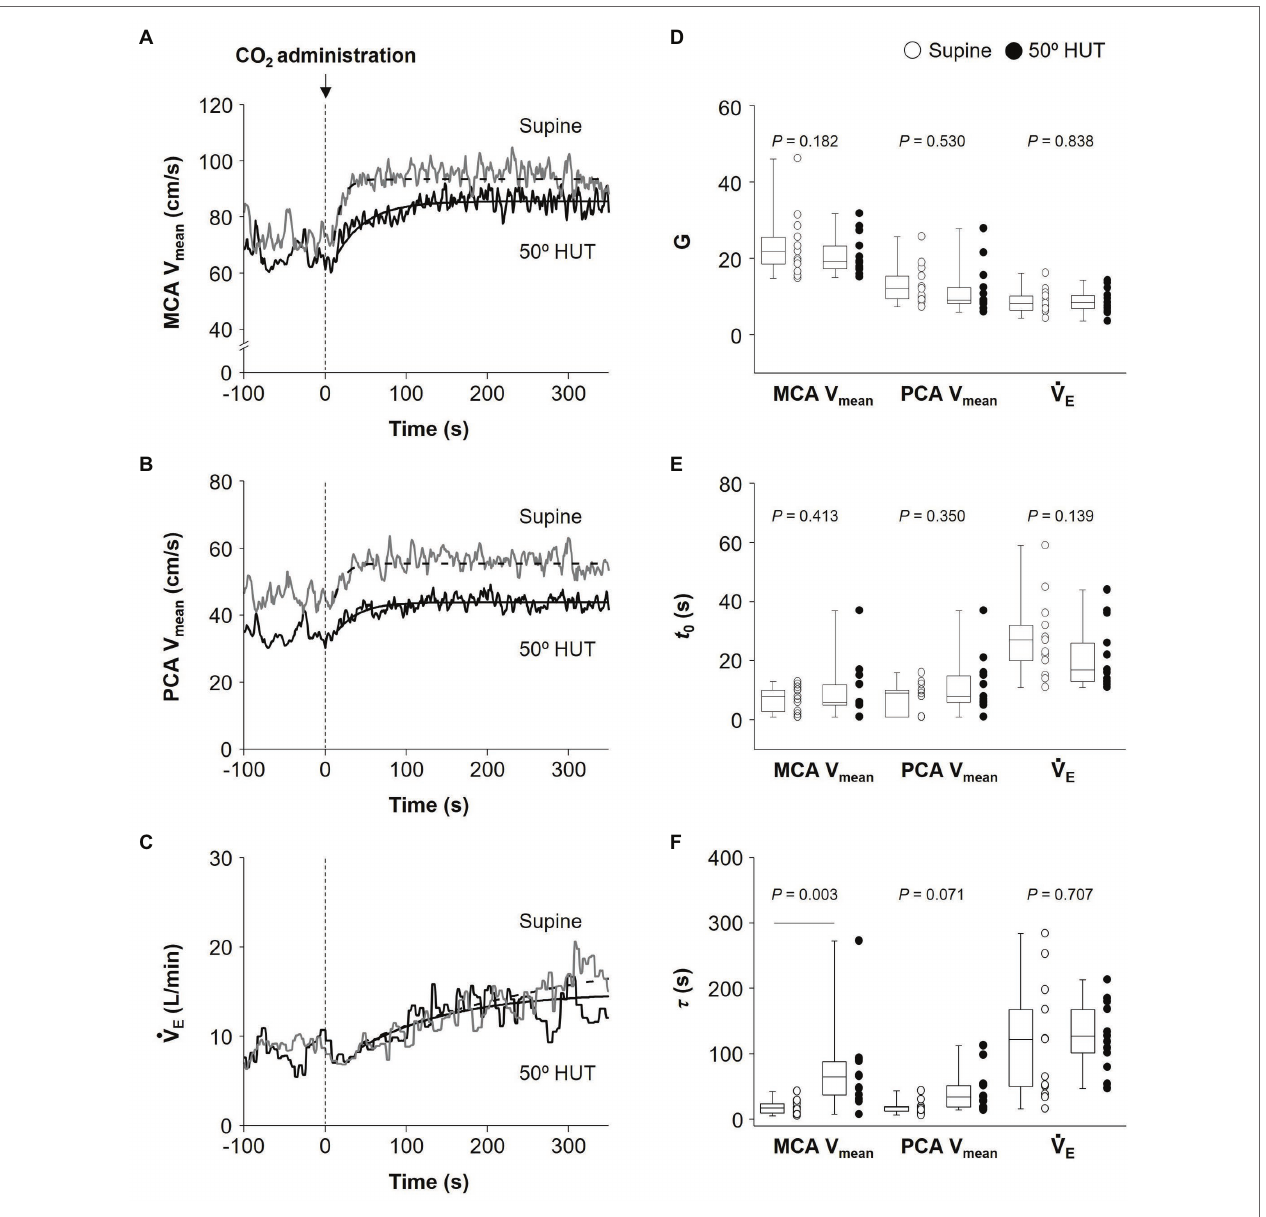
FIGURE 3 | Dynamic cerebrovascular carbon dioxide (CO 2 ) reactivity and central respiratory chemoreflex were characterized using a single-exponential regression model. Panels A–C : Continuous recordings of middle and posterior cerebral artery mean blood velocities (MCA V mean , A and PCA V mean , B) and pulmonary ventilation (. V E , C) response to CO 2 administration (5% CO 2 ) during hypercapnia during supine (gray line) and 50 ° head-up tilt (HUT; black line) in one representative participant. The dash-dotted and smooth curve represent the exponential lines at supine and 50 ° HUT, respectively. Panels D–F : Grouped gain (G, D), CO 2 -response delay ( t 0